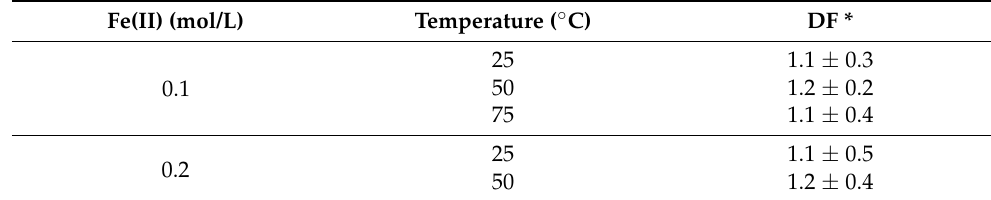
Table 3. Results of decontamination of the model SIER under dynamic conditions by the 0.1 M solution of H 2 SO 4